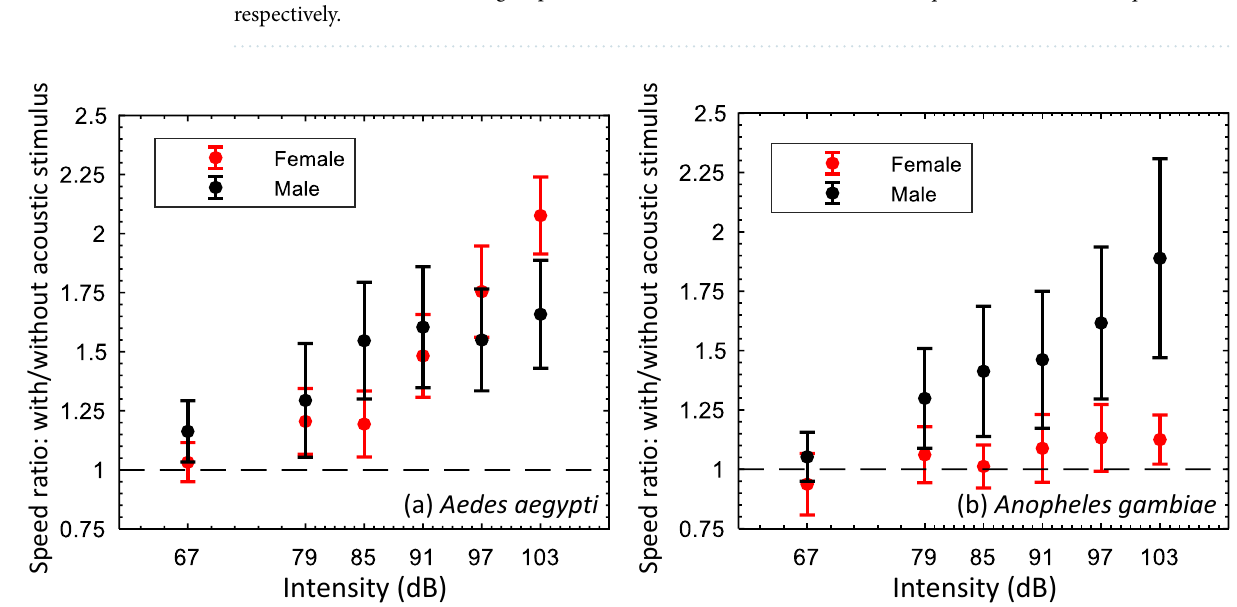
Figure 4. The ratio of mosquito flight speed with/without an acoustic stimulus, at different acoustic intensities, at a fixed frequency of 400 Hz for males and 200 Hz for females. ( a ) and ( b ) are for Aedes and Anopheles ,